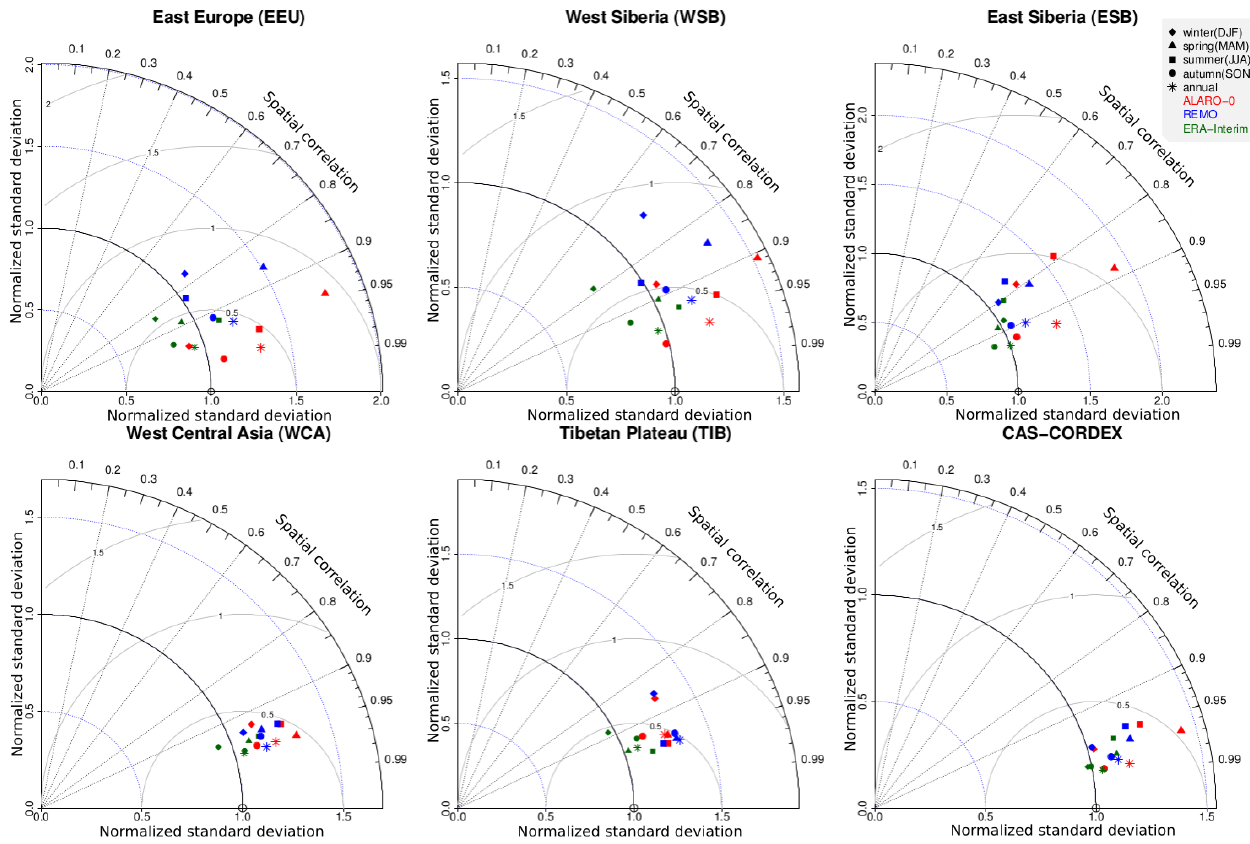
Figure 9. Normalized Taylor diagram showing the model spatial performance in terms of the maximum temperature for seasonal and annual means for both RCMs (ALARO-0 and REMO) and ERA-Interim reanalysis with respect to CRU for the five subregions and the complete CAS-CORDEX